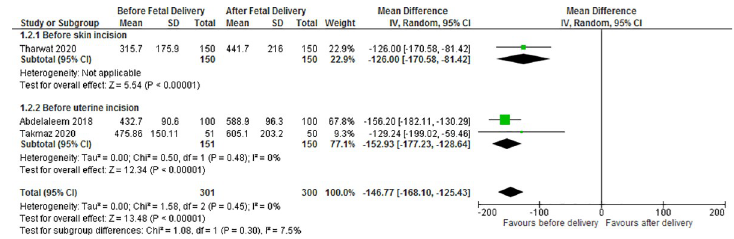
Fig 4. Forest plot of oxytocin given before versus after fetal delivery. Outcome: volume of blood loss.